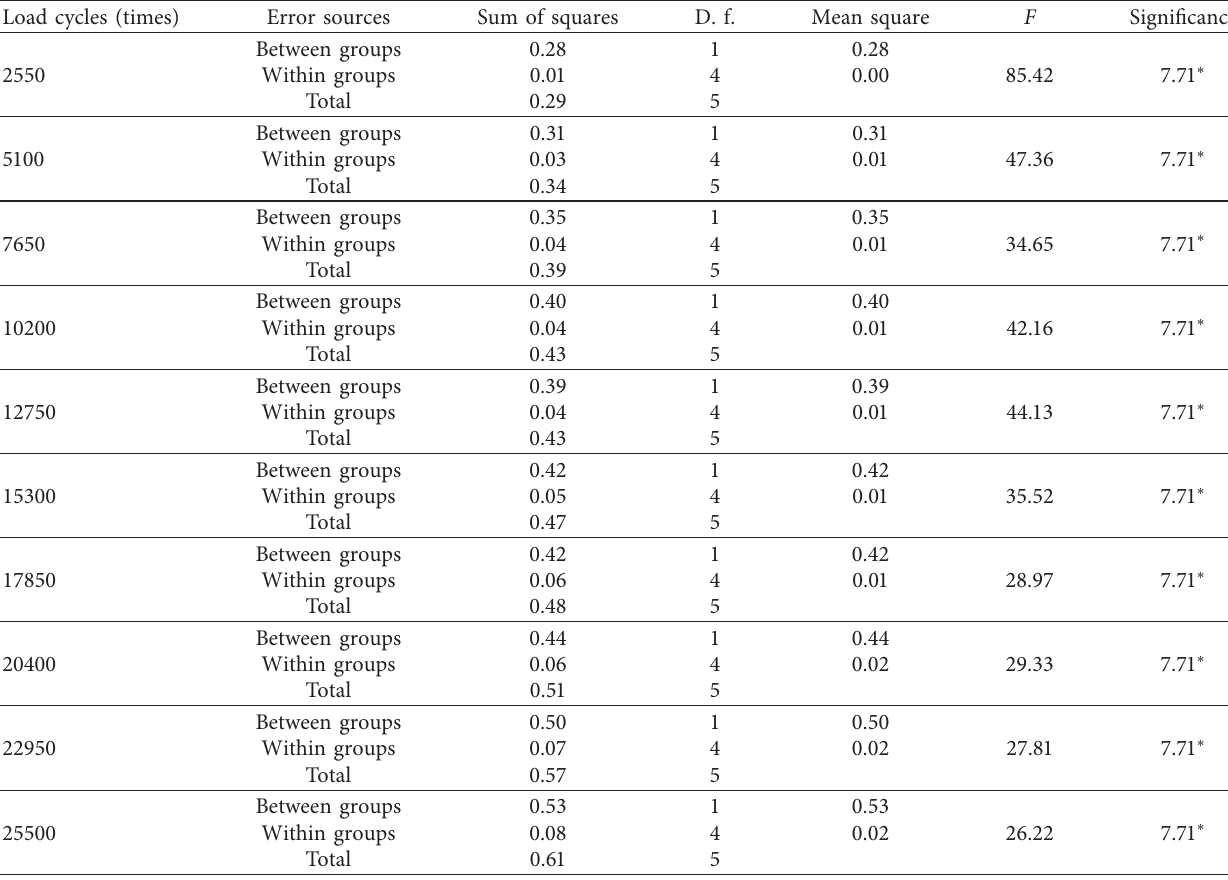
Table 10: Differences between the rut depths of two pavement structures with the same number of load cycles (load pressure � 1.2MPa). Load cycles (times)